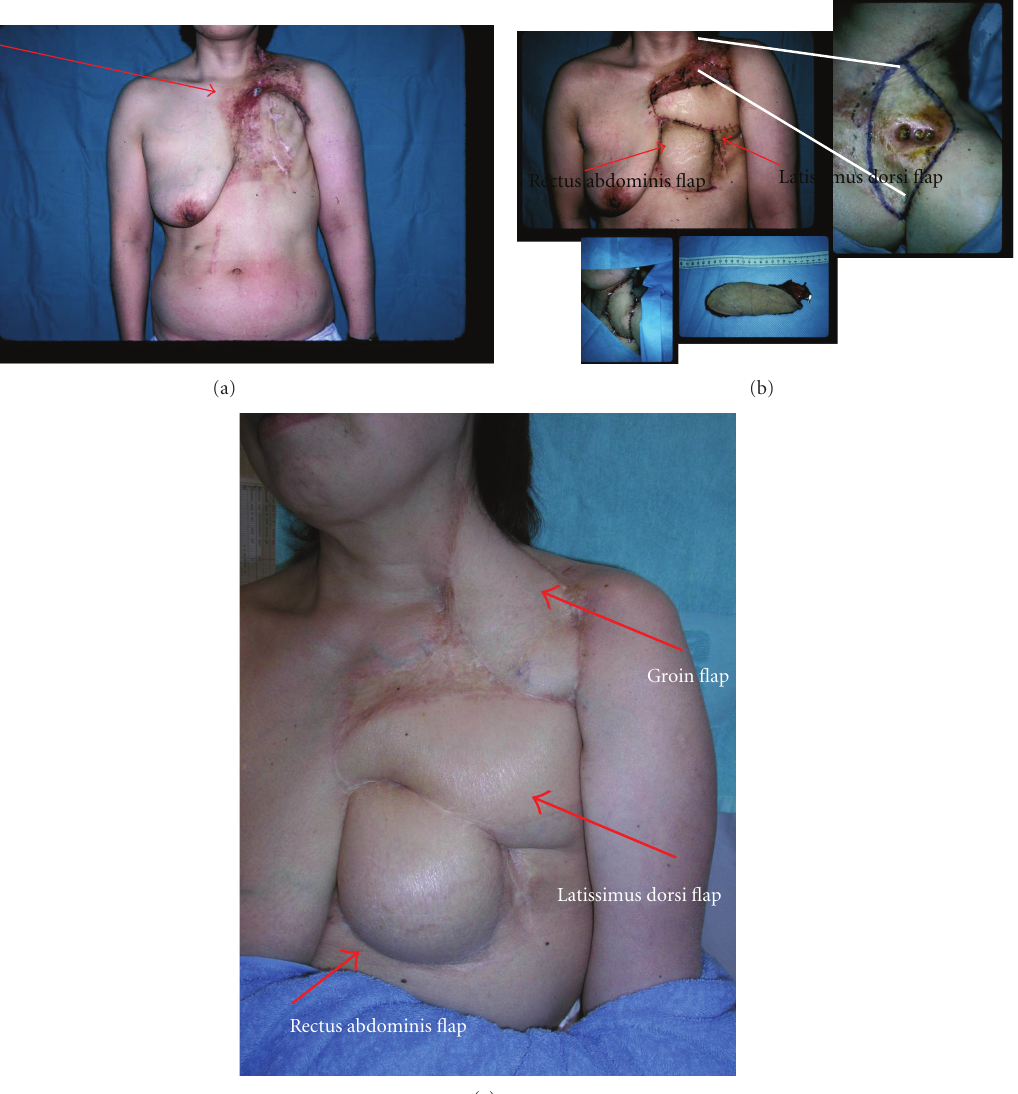
Figure 5: 55-year-old woman underwent a left breast cancer surgery by a standardized Halsted methods, followed by 50-Gy fractionate radiation therapy 15 years previously. (a) The chest demonstrates fistula to the costal rib and adjacent to the pleura as the arrow depicts, and the surrounding tissues were firm and various-degree inflammation existed. (b) Sequential three major flaps (rectus abdominis, latissimus dorsi, and free groin flap) are used for total coverage. (c) In 7 years postoperative view. There is irregularity of the scar